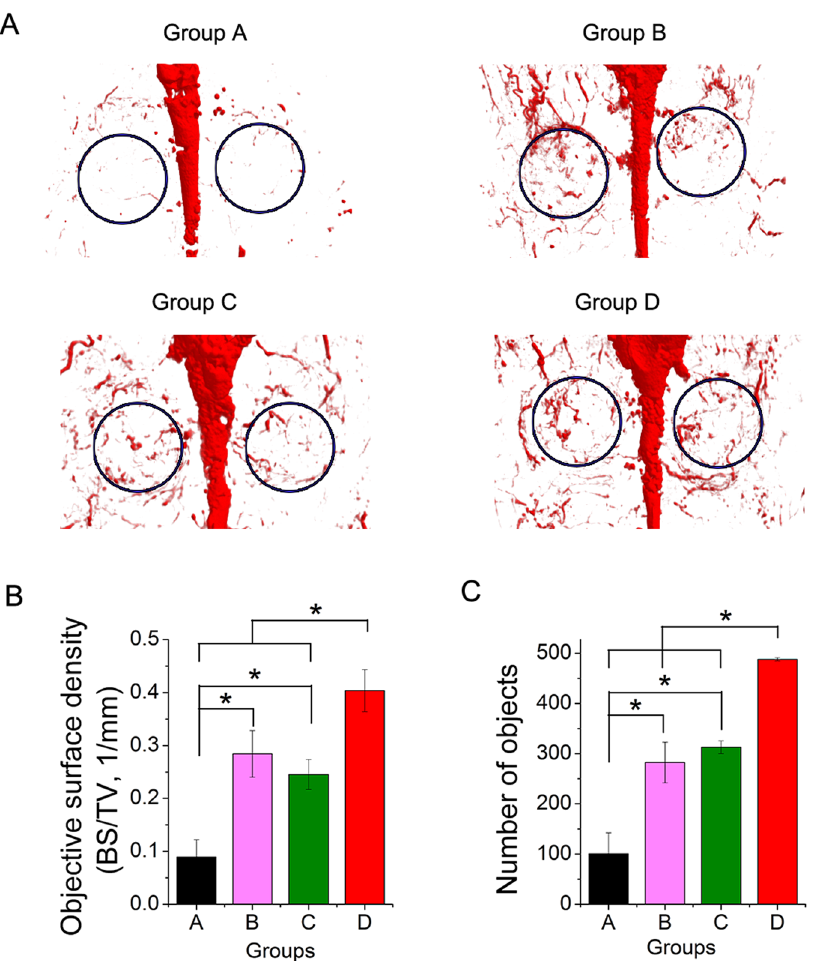
Figure 7. Histological images of newly formed blood vessels in calvarial defects for groups CPC(Group A), CPC/ICA-2 000 (Group B), CPC + ICA-ig (Group C) and CPC/ICA-2 000 + ICA-ig (Group D) that were taken at 8 weeks after the operation. ( B , C ) The objective surface density and objects number of newly formed blood vessel were assessed by histomorphometric analysis ( * p <